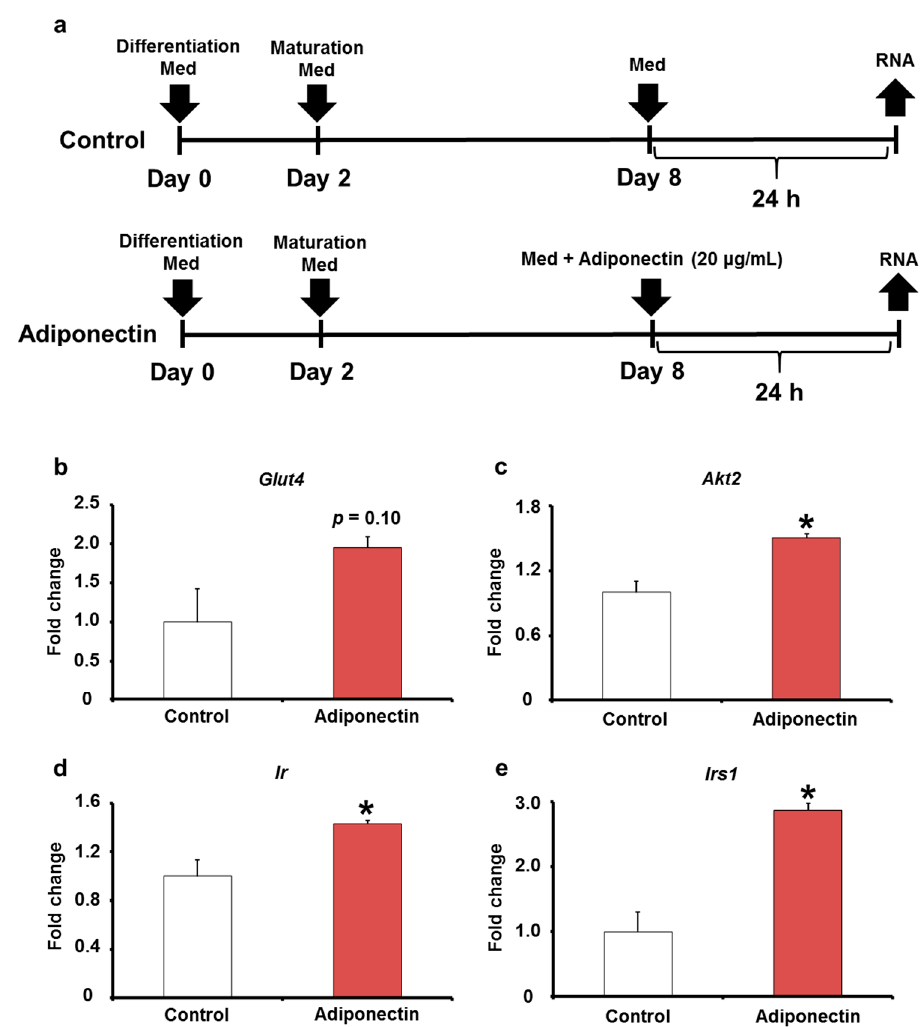
Figure 7. Effect of adiponectin on insulin signaling-related molecule expression in 3T3-L1 adipocyte. ( a ) Experimental design. ( b – e ) The relative mRNA expression levels of Glut4 , Ir , Irs1 , and Akt2 in 3T3-L1 adipocyte were measured by quantitative reverse-transcription polymerase chain reaction ( n = 3). Values are presented as the mean ± SE. * p < 0.05 vs. control group.